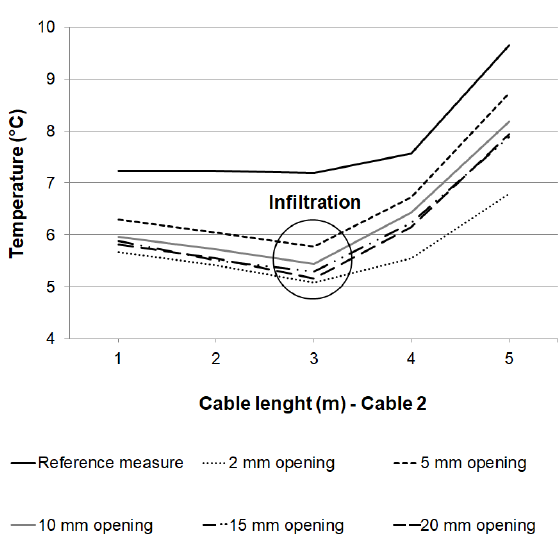
Figure 4 - Temperature-lenght: cable